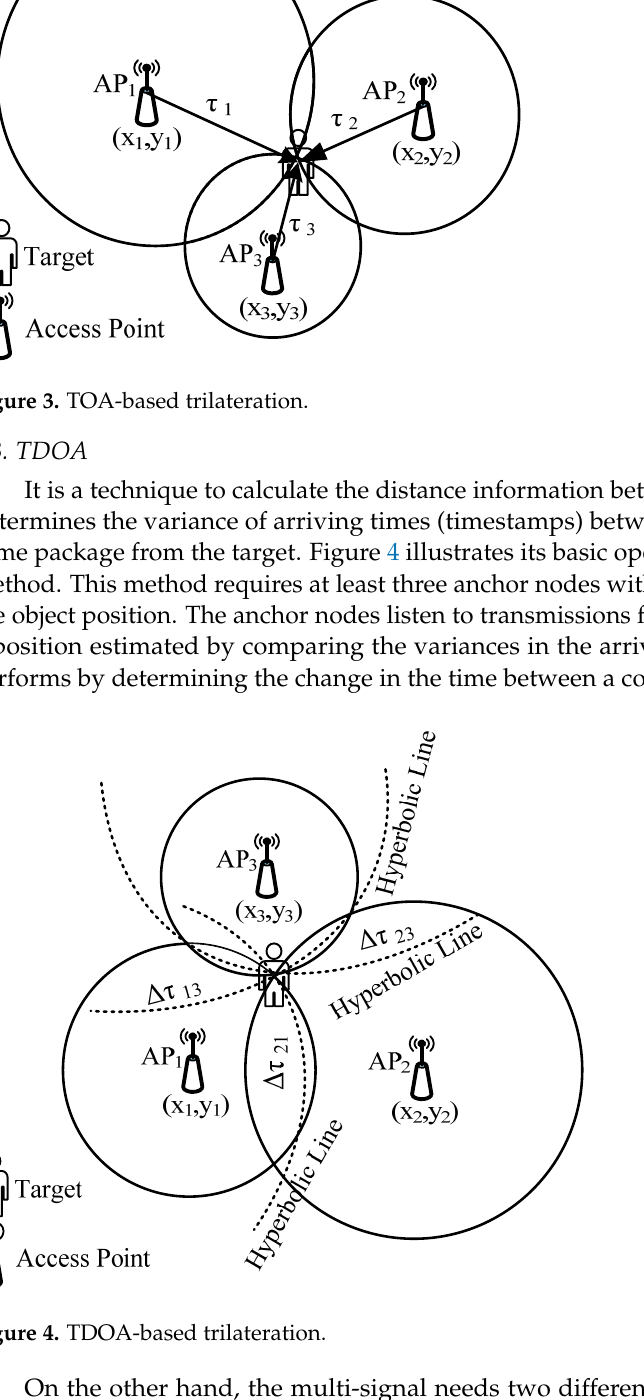
Figure 3. TOA ‐ based trilateration.